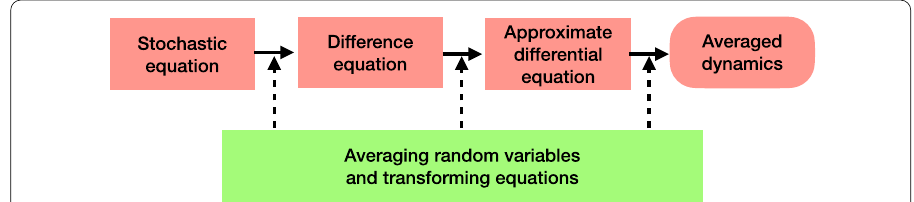
Fig. 1 The mean-field approach for finding the dynamics of expected values of s i ( t ) and β i ( t )